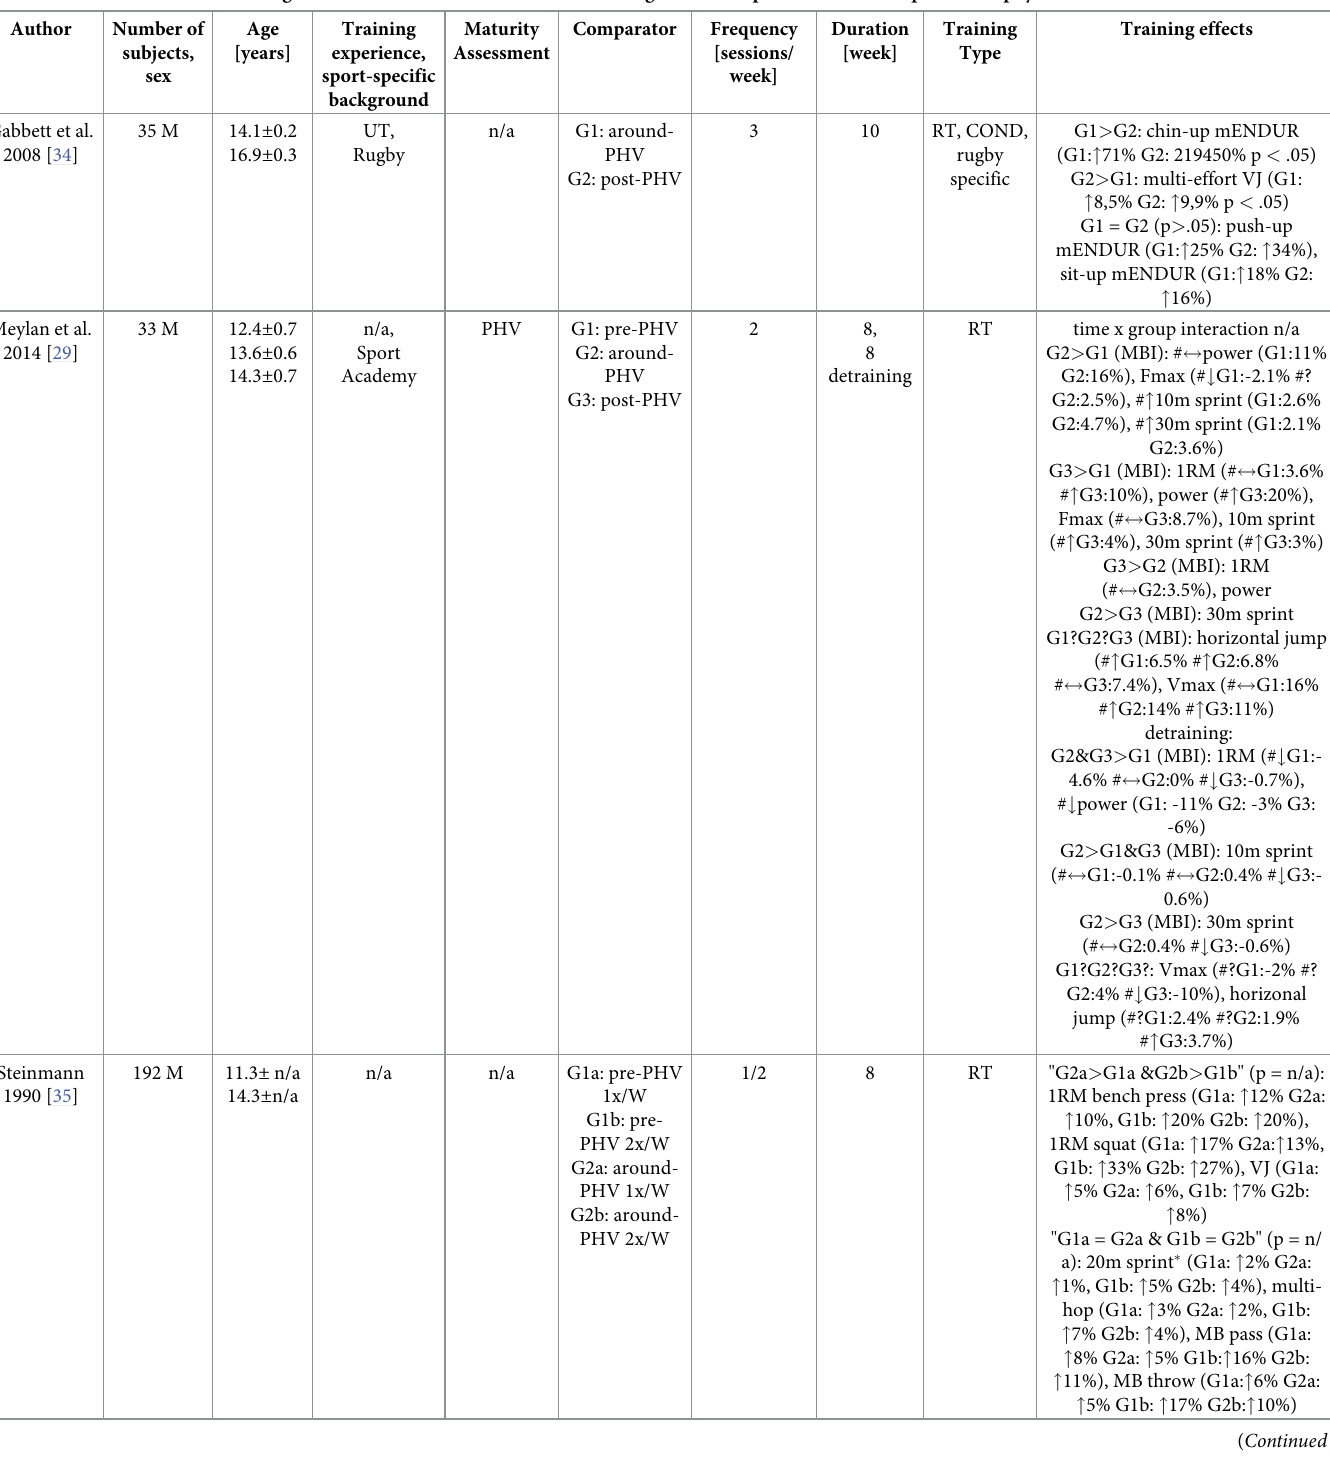
Table 1. Influence of the moderating variable ‘maturation’ on resistance training induced improvements in components of physical